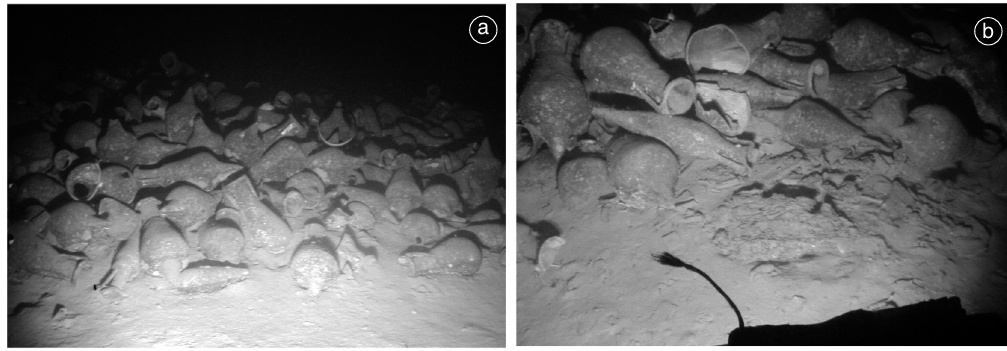
Fig. 8a,b. Two different views of the extensive submerged heap of Spanish amphorae.